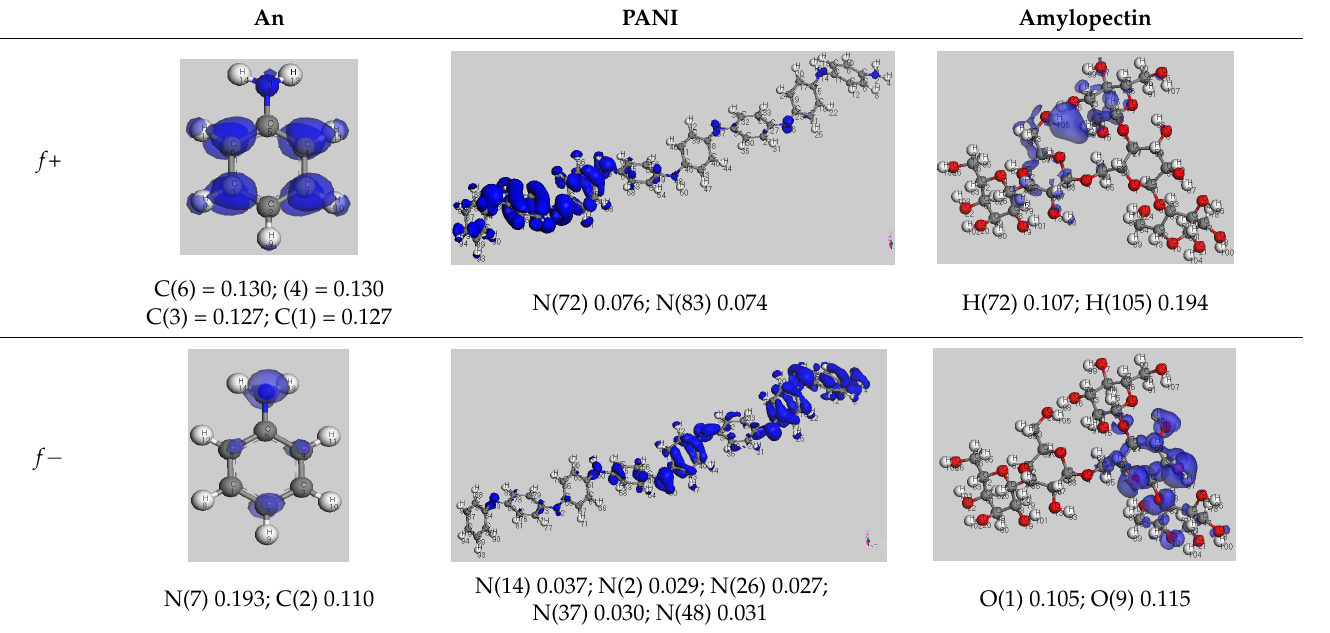
Table 11. Fukui analysis of aniline, polyaniline, and amylopectin: The nucleophilic term f_k^+; the electrophilic term f_k^- values of the Fukui function. PANI Amylopectin